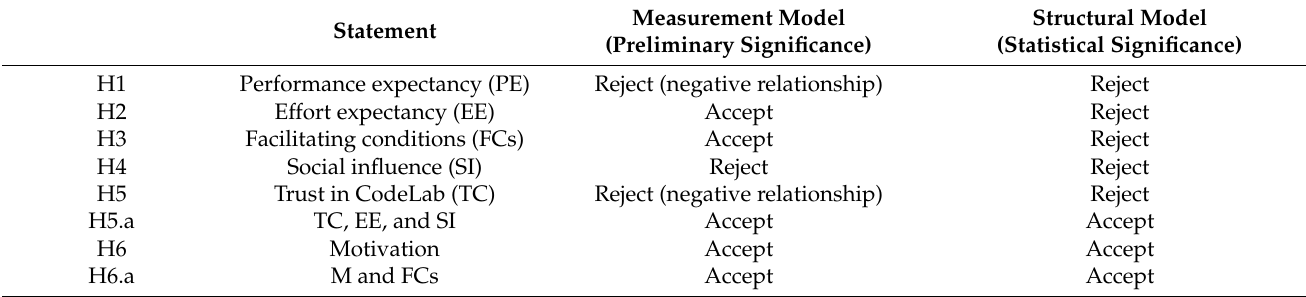
Table 4. Hypothesis testing